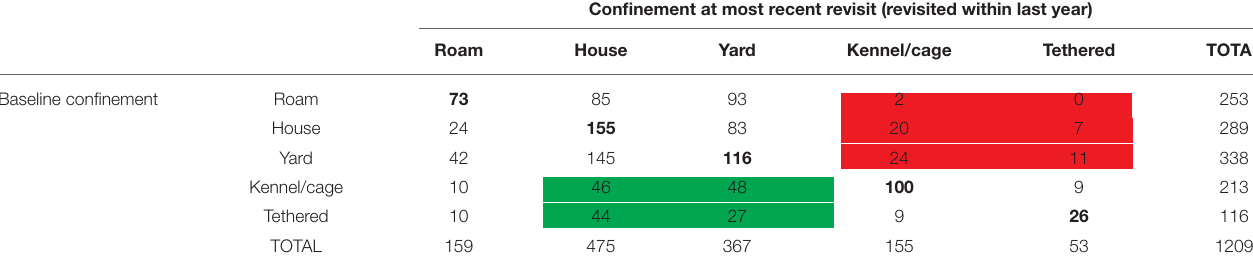
TABLE 2 | Transition matrix of confinement practices for dogs scored at baseline and at their most recent visit. Confinement at most recent revisit (revisited within last year)